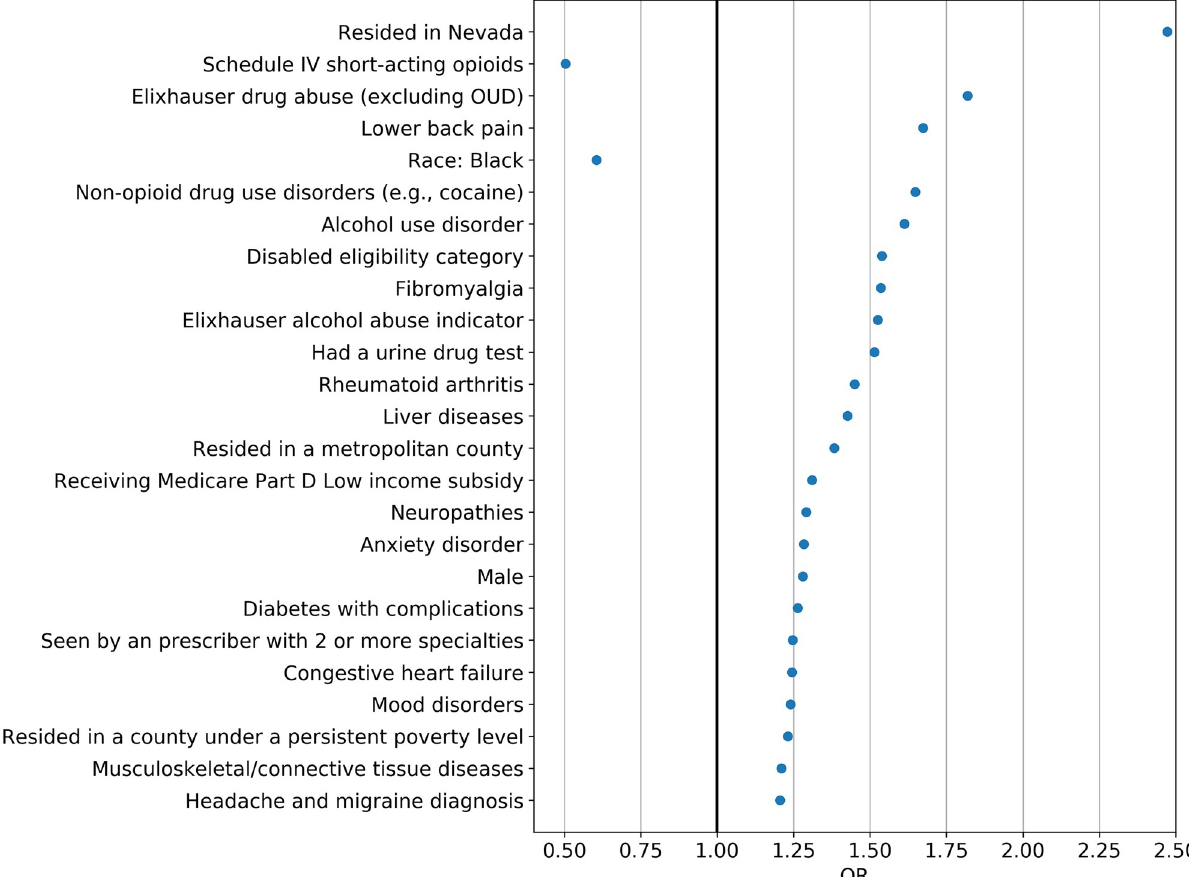
Fig 3. Top 25 predictors for opioid use disorder identified by elastic net (ordered by importance) a . a Figure shows the important predictors ordered by feature importance based on odds ratios. EN regularization does not provide an estimate of precision and therefore 95% confidence intervals (95% CI) were not provided. Abbreviations: OR: odds ratios; OUD: opioid use